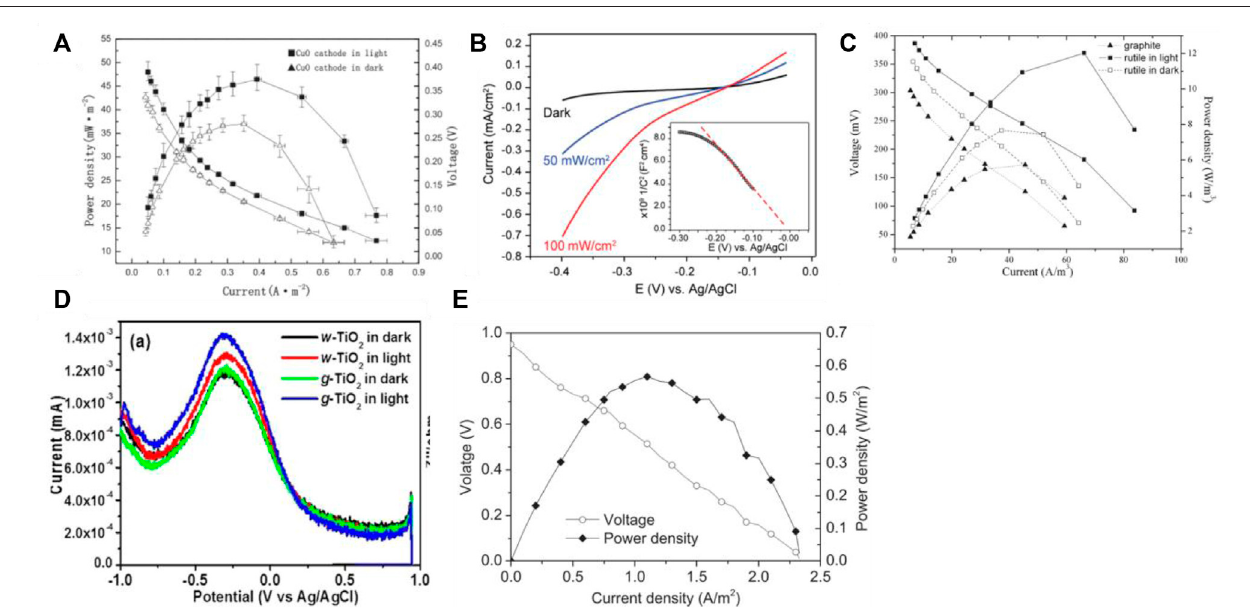
FIGURE 4 | (A) Power density curves of PMFC with nanowire arrays of CuO as photocathode (Sun et al., 2015); (B) Power density curves of PMFC with Cu 2 O nanowirearraysasphotocathode(Qianetal.,2010); (C) PowerdensitycurvesofPMFCwithrutile-coatedgraphiteasphotocathode(Luetal.,2010); (D) DPV(differential pulse voltammetry) curves (Khan et al., 2018); (E) power density curves of PMFC with PANi@CNTs/SS as bioanode and CuInS 2 as photocathode (Xu et al.,